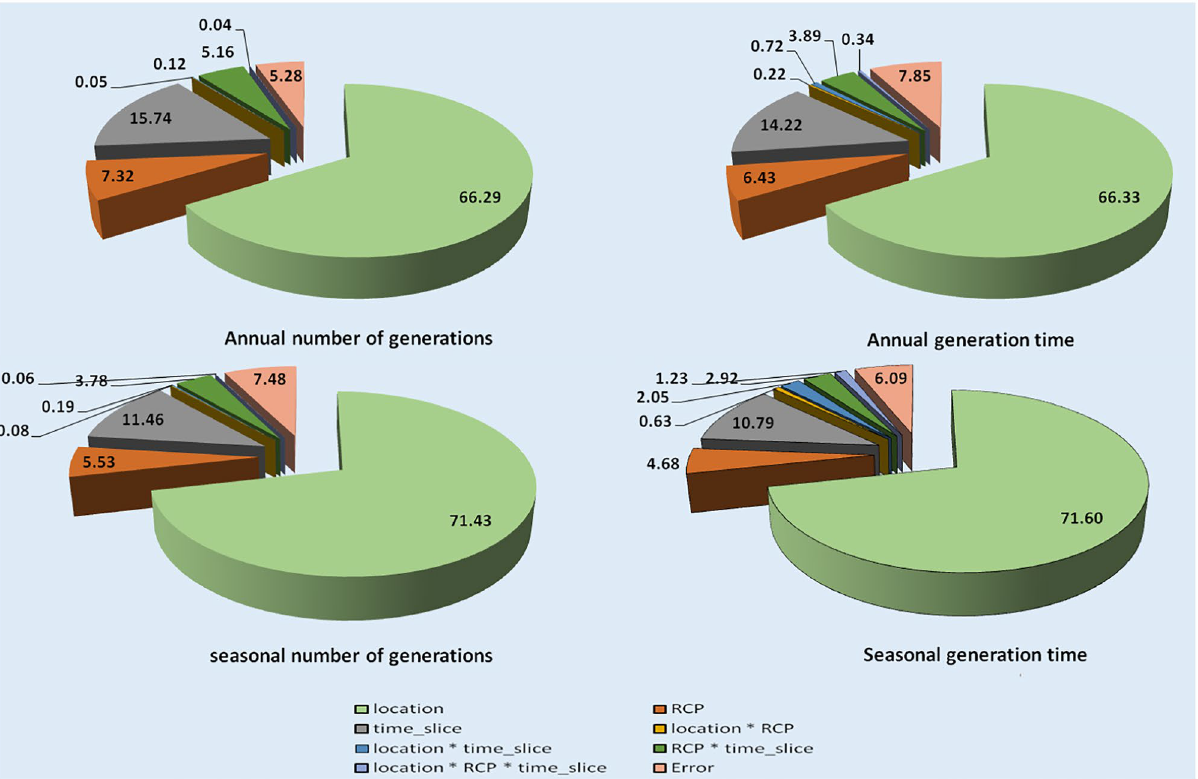
Figure 5. Estimated proportion of variation in predicted no. of gen. and gen. time of H. armigera by different